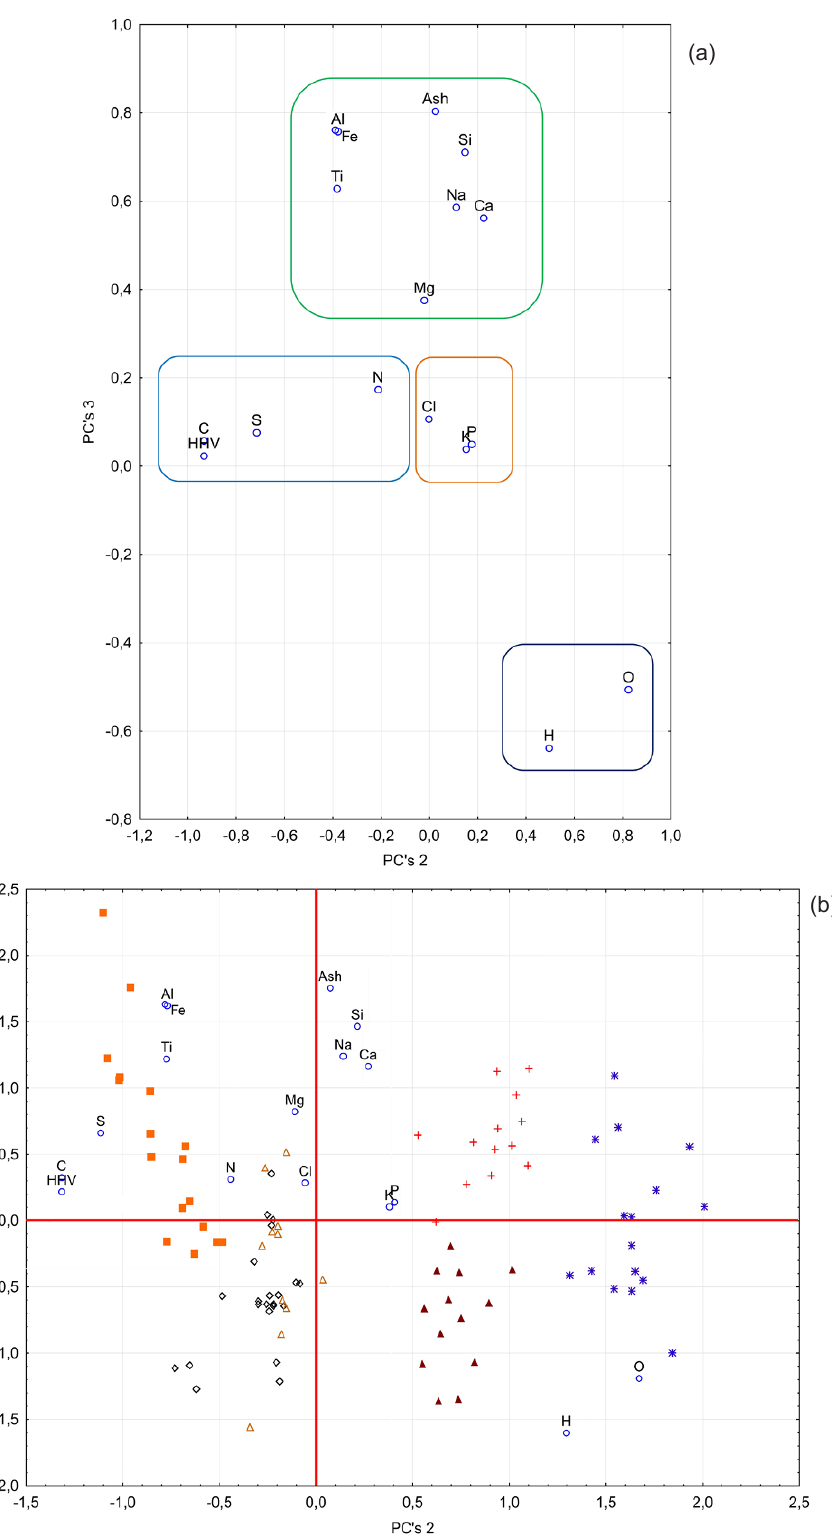
Figure 4. Plot of Principal Component Analysis of a) analysed variables, b) analysed